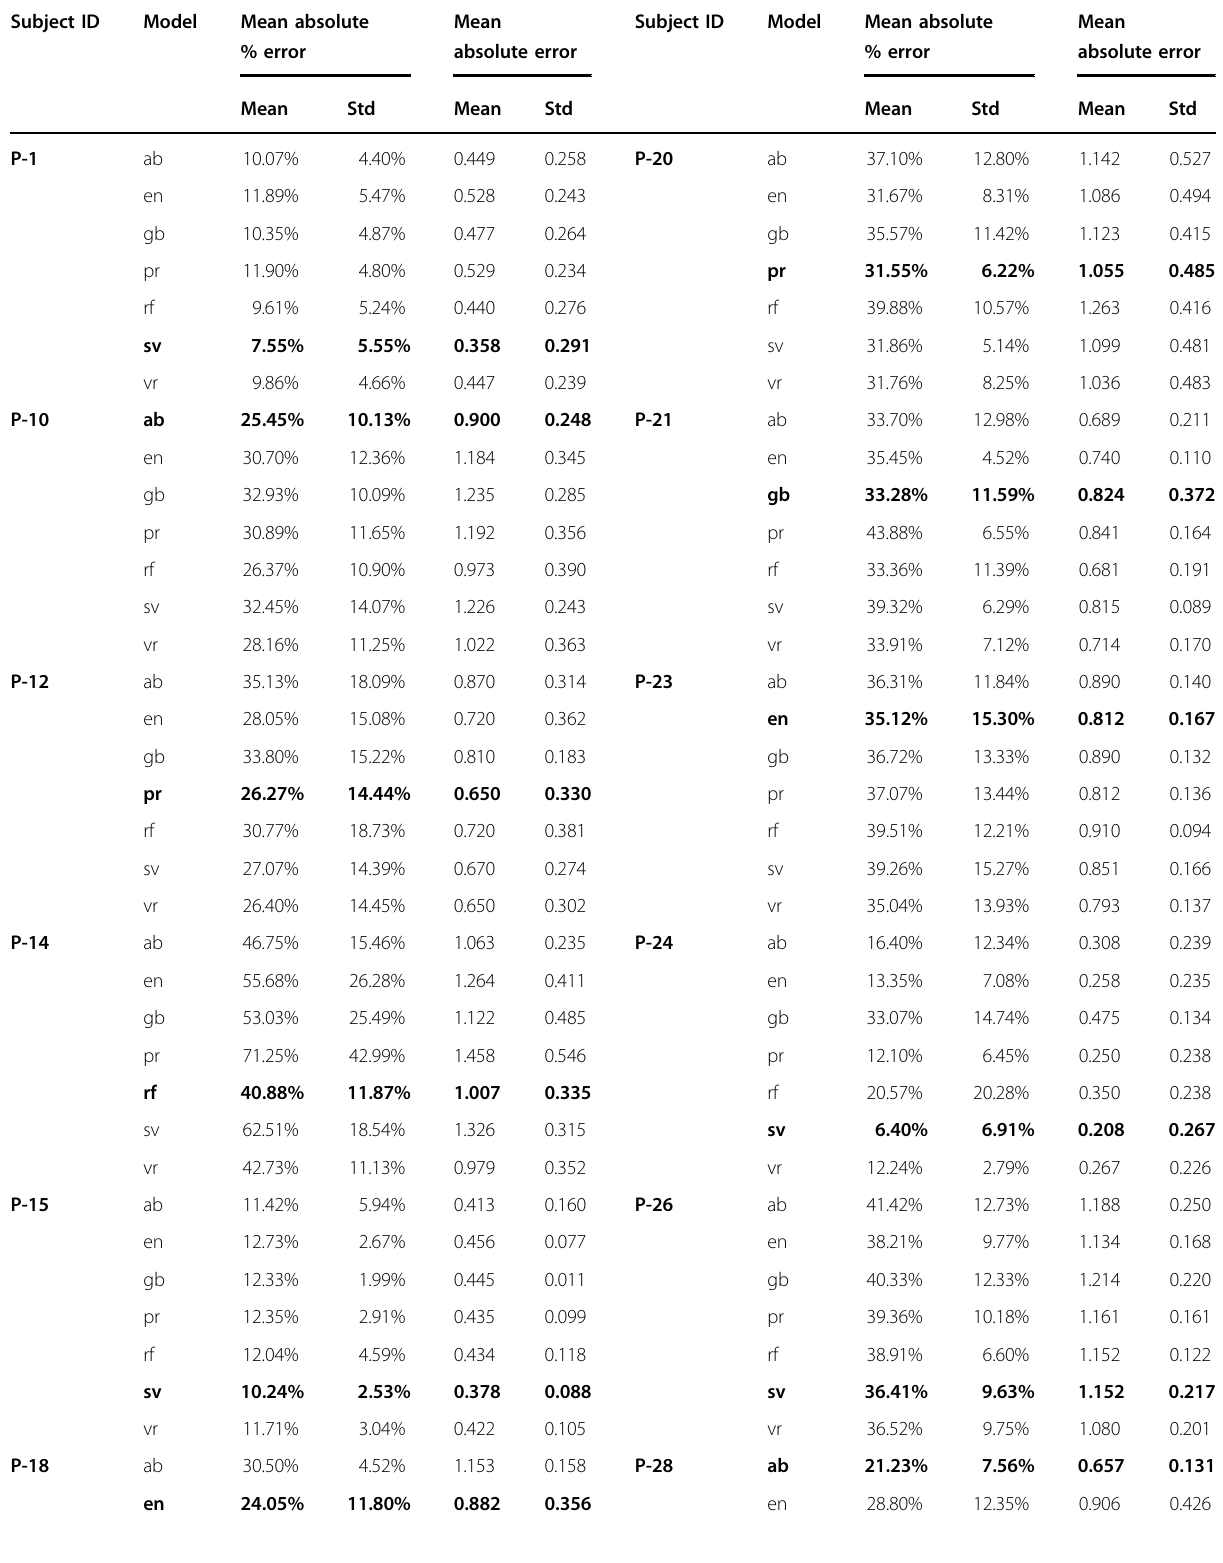
Table 1 Summary of the performance of each personalized ML strategy conducted individually in